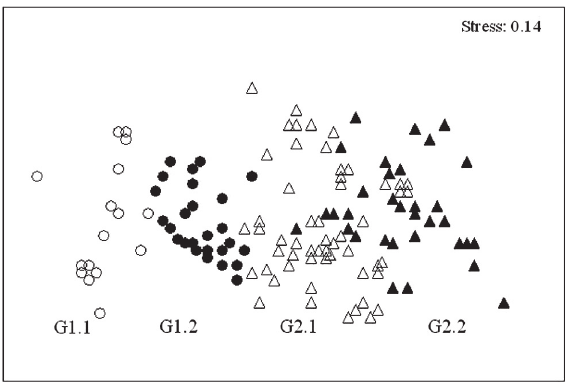
Fig . 4. – MDS ordination of the amphiatlantic species based on their presence-absence in the zoogeographic areas. White circles, species of subgroup G1.1; black circles, species of subgroup G1.2; white triangles, species of subgroup G2.1; black triangles, species of subgroup